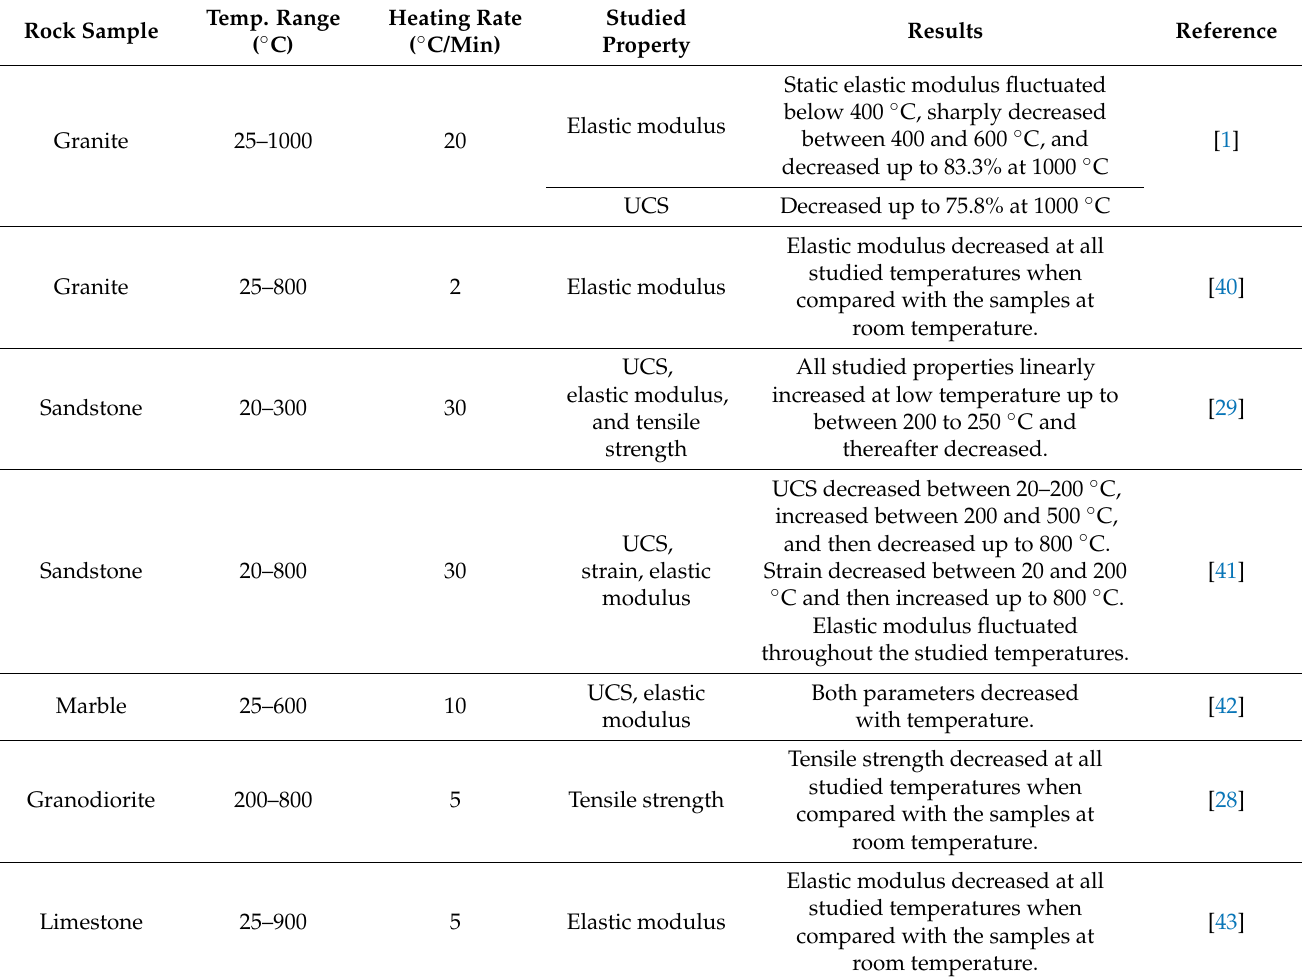
Table 1. Effect of temperature on mechanical rock